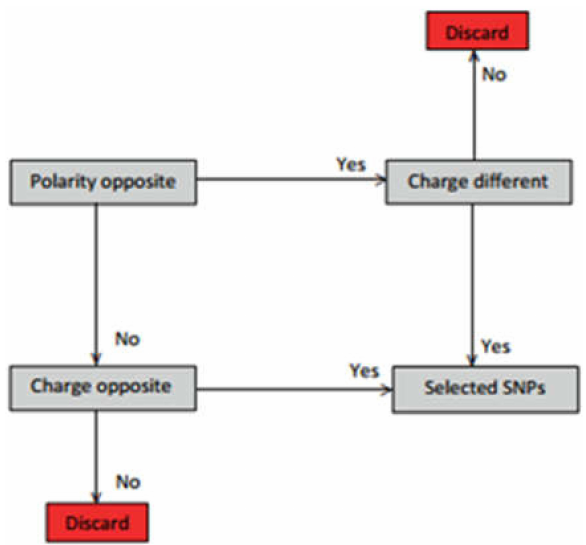
Figure 5. Amino acid change/SNP selection criteria according to the change in amino acid polarity and